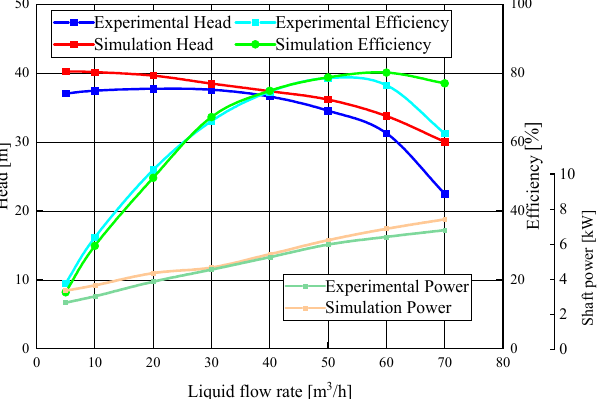
Figure 5. Comparison of the experimental test and the numerical results.